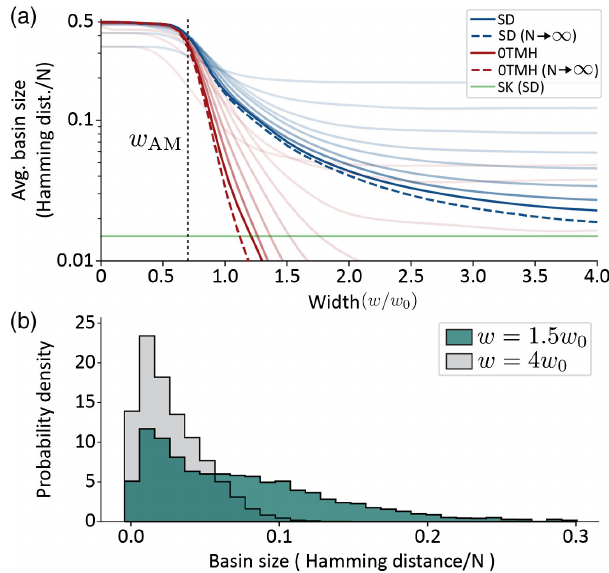
FIG. 12. (a) The average basin size in the CCQED system versus width of the spin ensemble distribution w . Metastable states are found by relaxing random initial seeds. Basin sizes for both 0TMH dynamics (red) and the (native) SD dynamics (blue) are shown. System sizes ranging from N ¼ 3 to N ¼ 800 are considered, with darker traces corresponding to larger sizes. We extrapolate to the limit N → ∞ by fitting a linear function of 1 =N to the finite N data. The intercept at 1 =N ¼ 0 yields the thermodynamic limit (dashed lines). The ferromagnetic-to- associative memory phase transition, indicating the onset of multiple metastable states, is marked by a vertical black dashed line at w . The green line shows the typical basin size under SD AM dynamics for the SK connectivity, 0 . 0135 ð 1 Þ N , as extracted from Fig. 11. (b) Histogram of the basin sizes found for widths w ¼ 1 . 5 w 0 and w ¼ 4 w 0